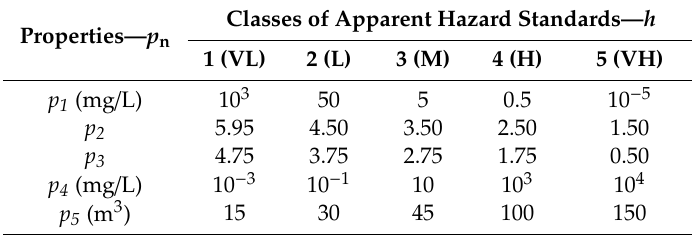
Table 2. Hazard pattern matrix ( Z p ). VL—very low; L—low; M—medium; H—high; VH—very high. Properties— p